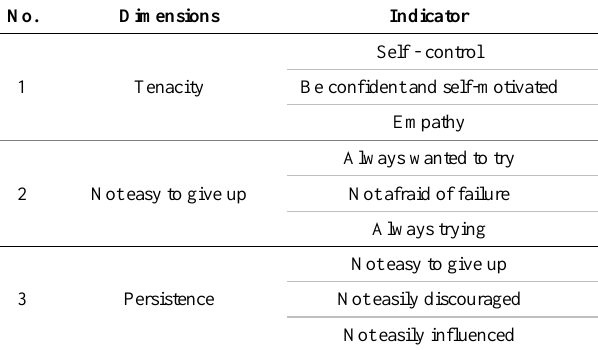
Table 3. Indicators of Child Mental